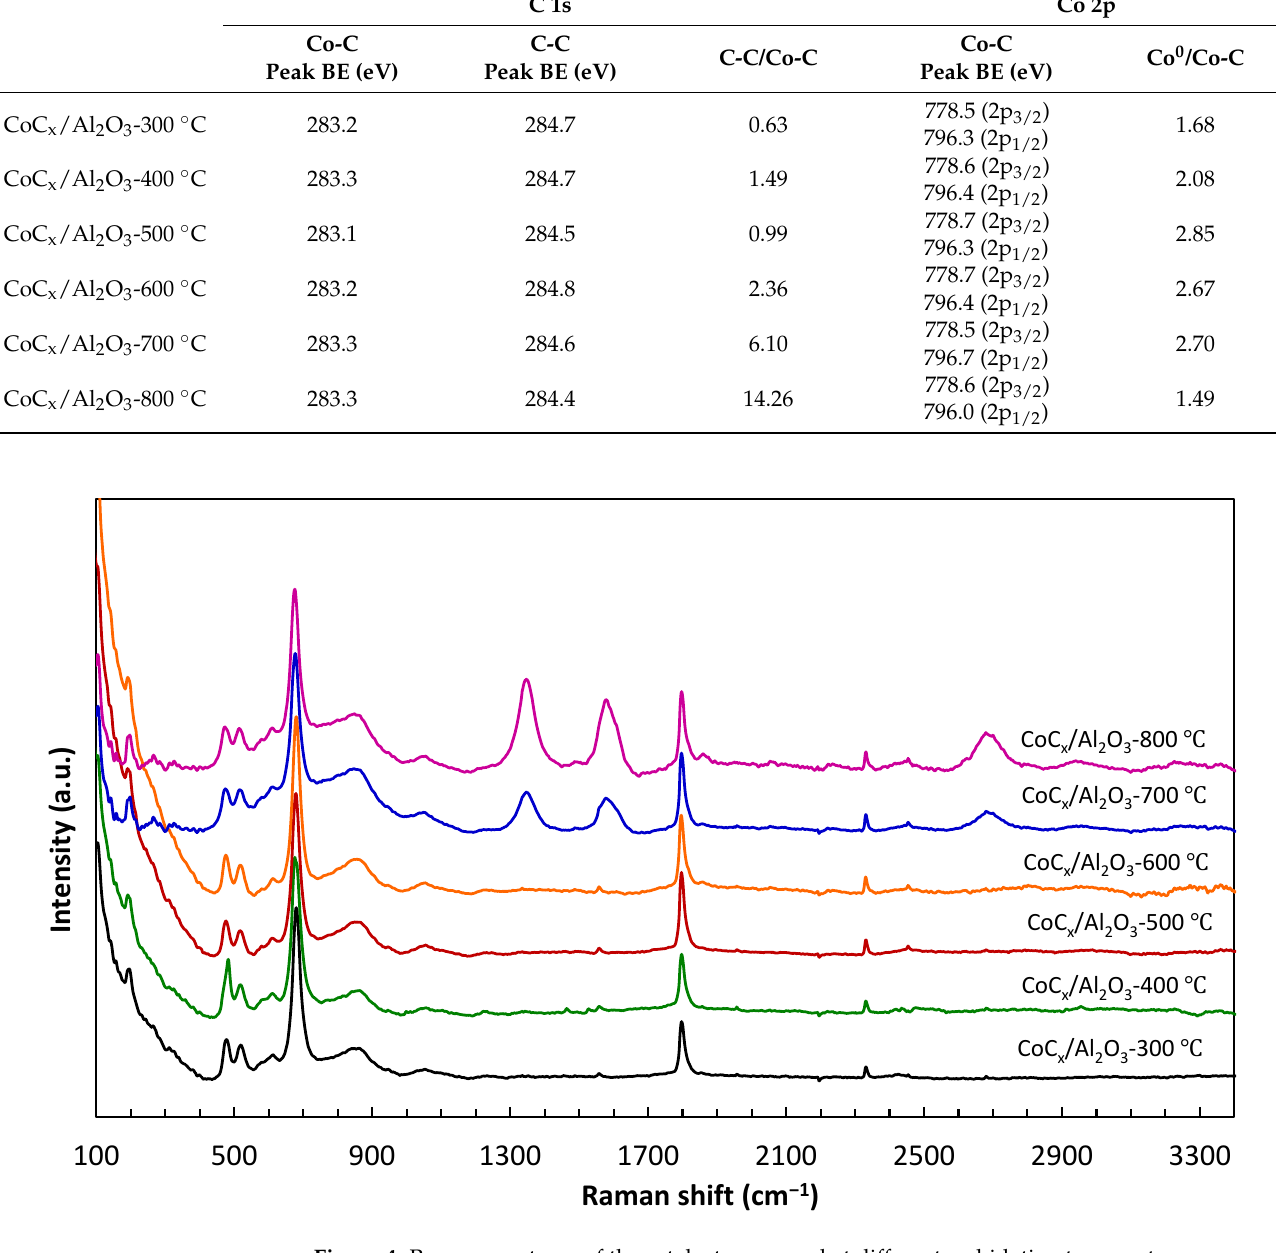
Figure 4. Raman spectrum of the catalysts prepared at different carbidation temperatures.